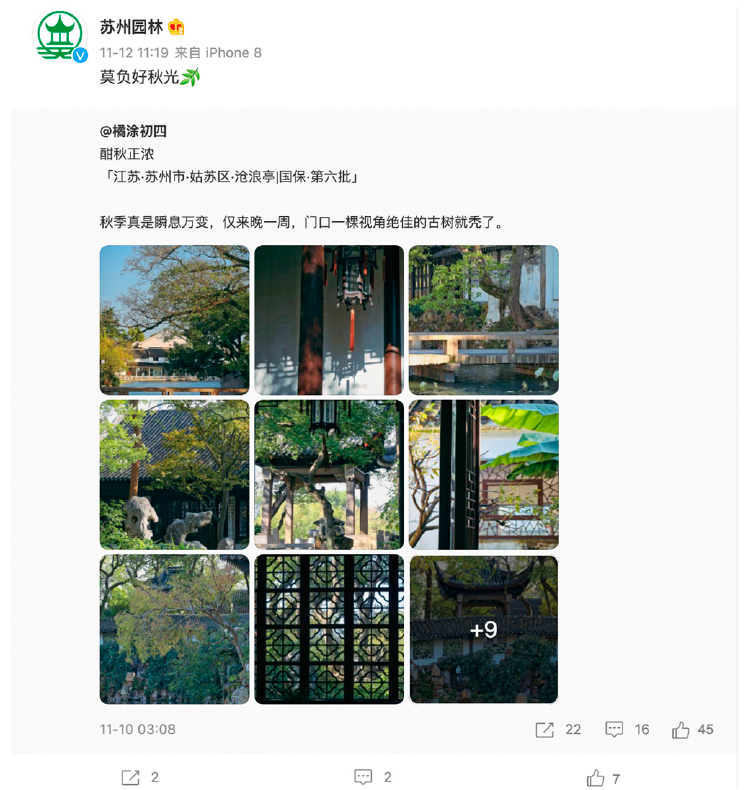
Figure 3. A reposted Weibo by Suzhou Gardens (verified as official account) commenting “don't miss the autumn” with pictures. Source: Weibo.com (https://weibo.com/suzhouyuanlinlvhua (accessed on 1 November 2021)).